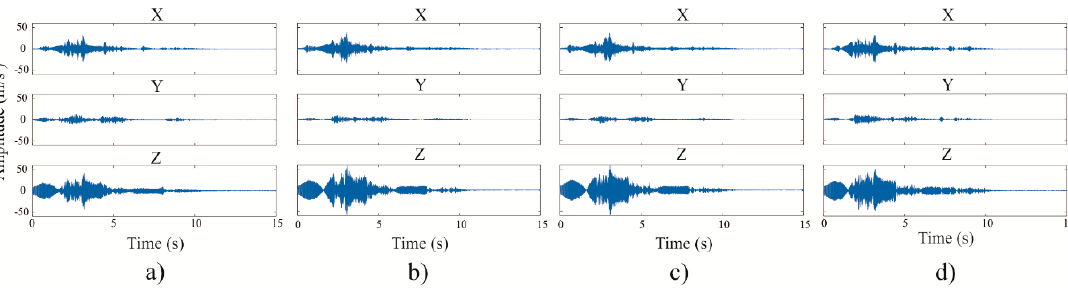
Figure 10. Measured vibrational signals in X, Y, and Z axes for ( a ) a healthy structure, ( b ) joint failure, ( c ) an external corrosion, and ( d ) an internal corrosion in the third bay.